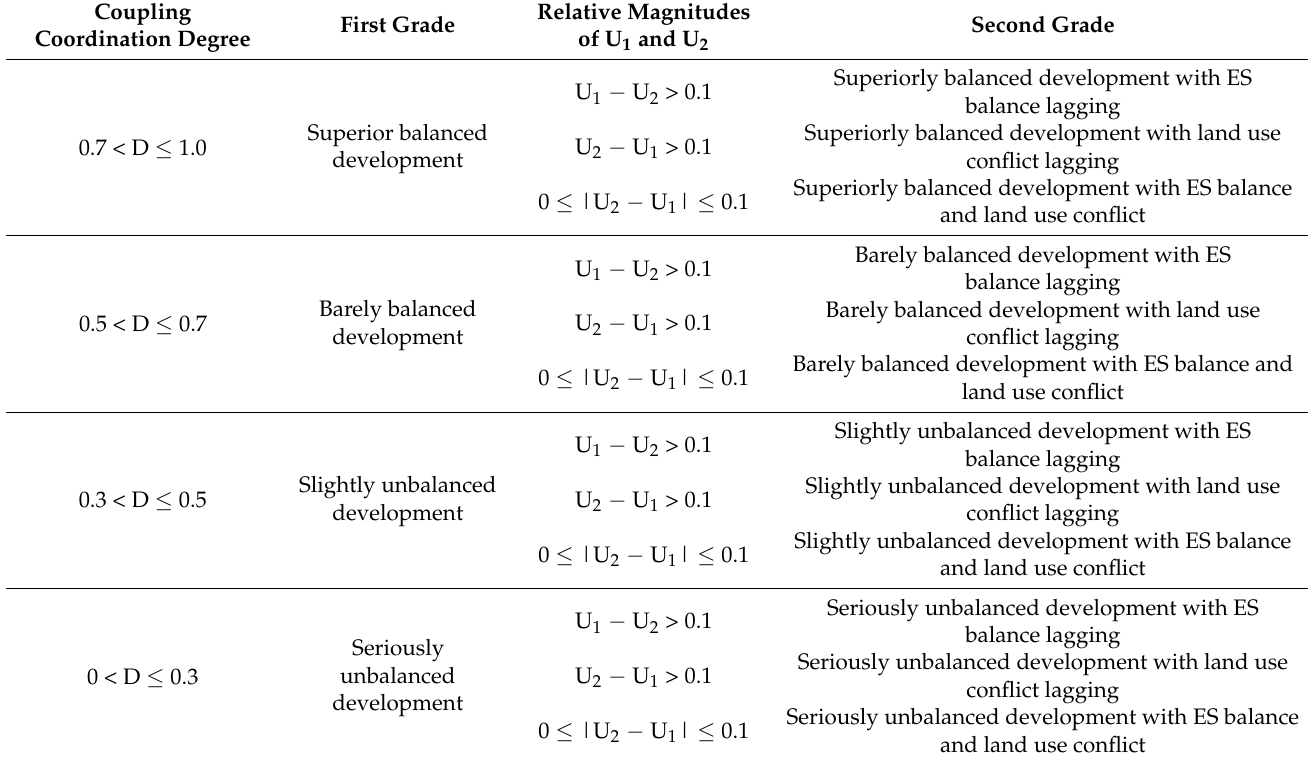
Table 1. Classification of the coupling coordination degree [36] of ES balance and land use